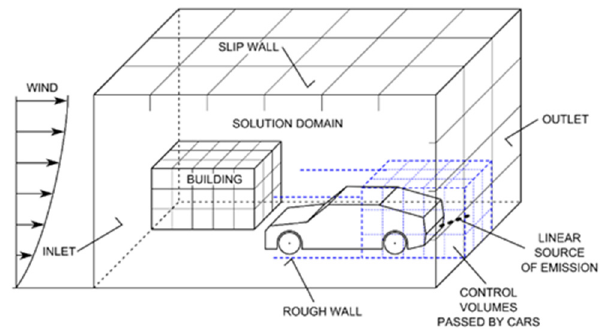
Figure 3. Schematic illustration of the modeled area and the assigned boundary conditions.